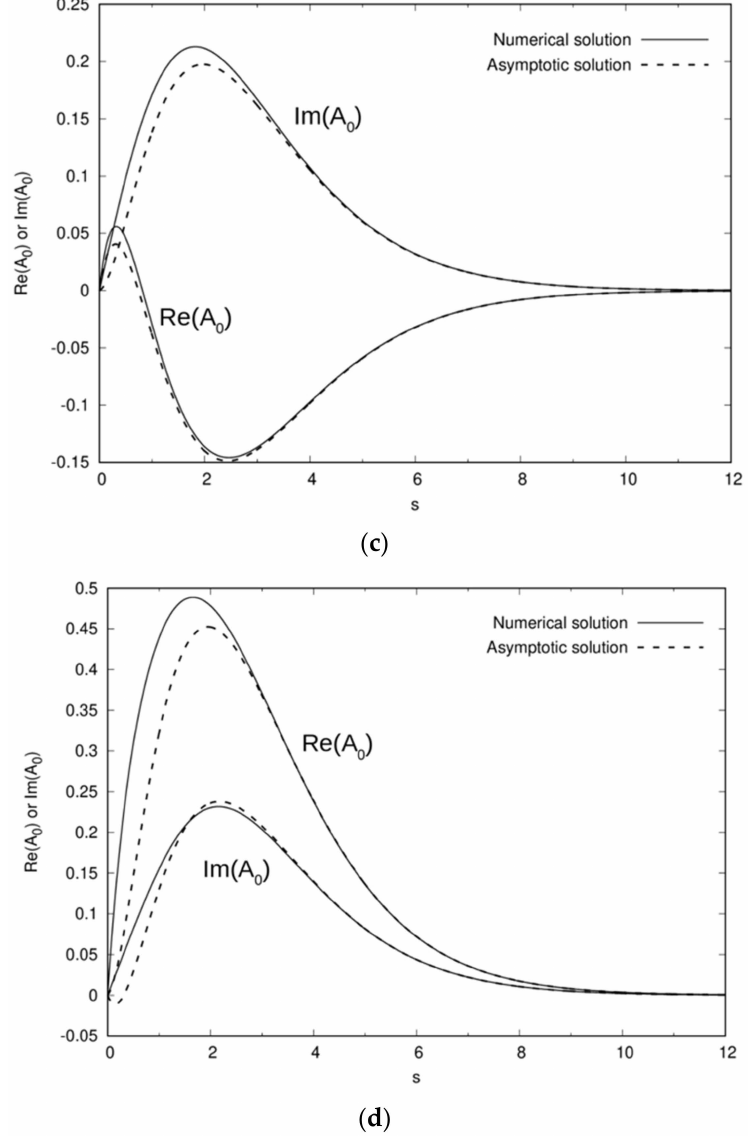
Figure 2. The solution of Equation (8) of Section 2 for ( a ) Ω = 0, ( b ) Ω = 0.5, ( c ) Ω = 1, and ( d ) Ω = 10, and where the exact solution of Ω = 0 is given by Equation (9). The asymptotic solution is of Equation